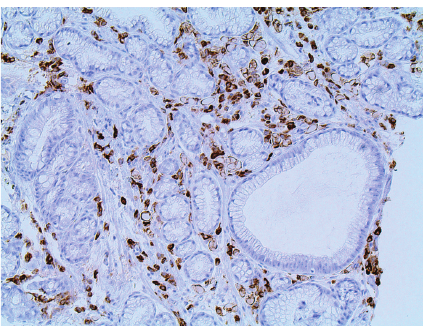
Figure 4: CD79a immunostain, 20x . The distended protein-con- taining cells in the lamina propria are highlighted by CD79a, a plasma cell